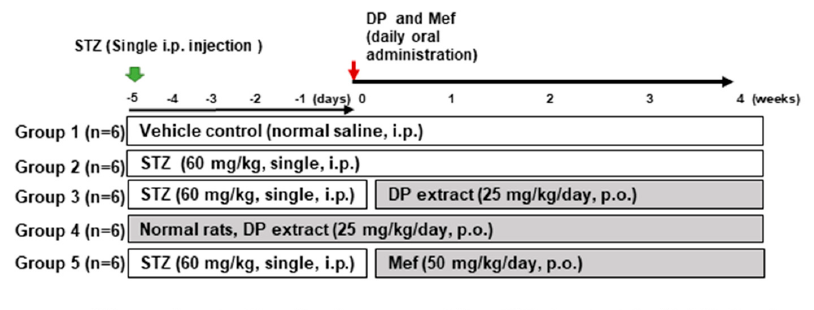
Figure 2. Experiment design. After one week of adaption, rats were divided randomly into five groups: (1) vehicle control (VC, n = 6); (2) STZ (60 mg / kg, single intraperitoneal (i.p.) injection); (3) STZ (60 mg / kg, single i.p. injection) + DP (25 mg / kg / day, oral gavage); (4) DP extract (25 mg / kg / day, oral gavage); and (5) STZ (60 mg / kg, single i.p. injection) + Mef (50 mg / kg / day, oral gavage). DP and Mef were administered daily for 4 weeks by oral gavage. STZ, streptozotocin; Mef,